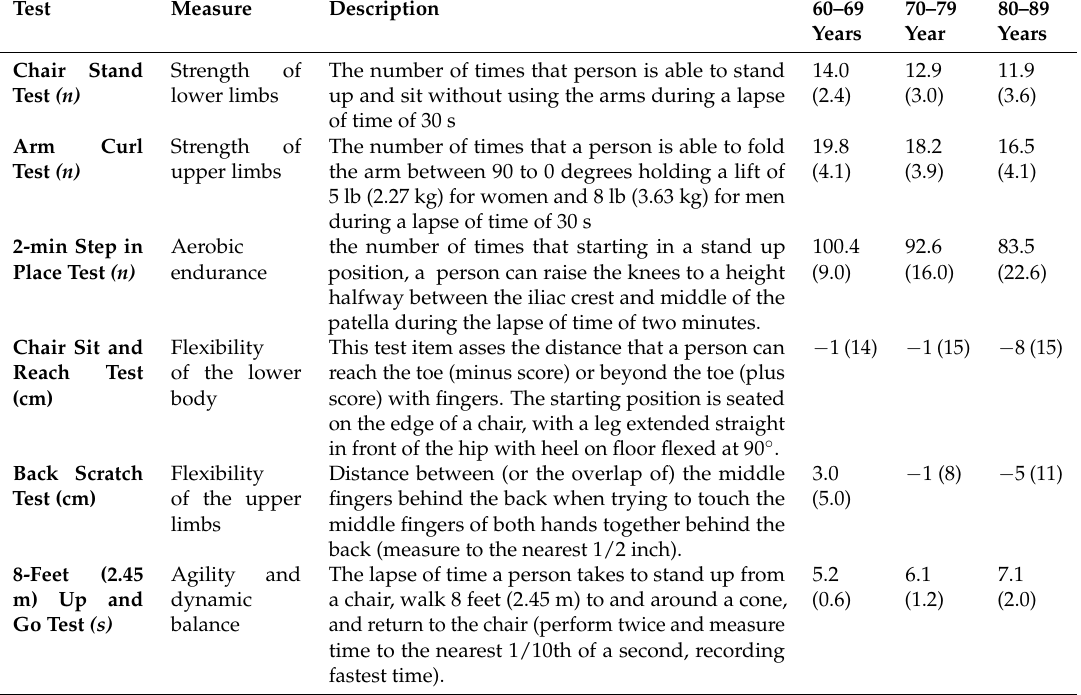
Table 1. Senior Fitness Test (SFT) tests